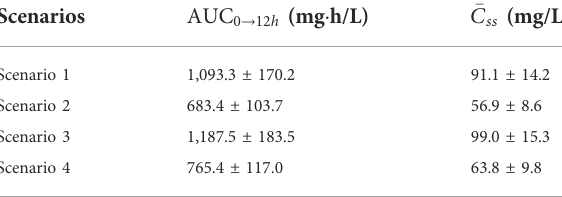
TABLE 7 Simulated steady-state area under the curve from time zero to 12 h (AUC 0 → 12 h ) and the corresponding average C ss ( (cid:2) C ss ) values of VPA under the dosage regimen of 500 mg/bid in terms of four different scenarios based on the XGBoost model.